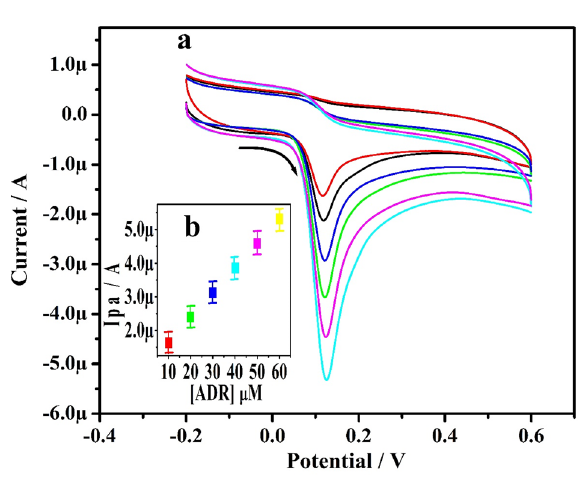
Figure 8. ( a ) CVs documented for different concentration of ADR (10–60 µM) using 0.2 M PBS (7.4 pH) at Po-ERY/MGPE. ( b ) Graph of Ipa Vs ADR concentrations.